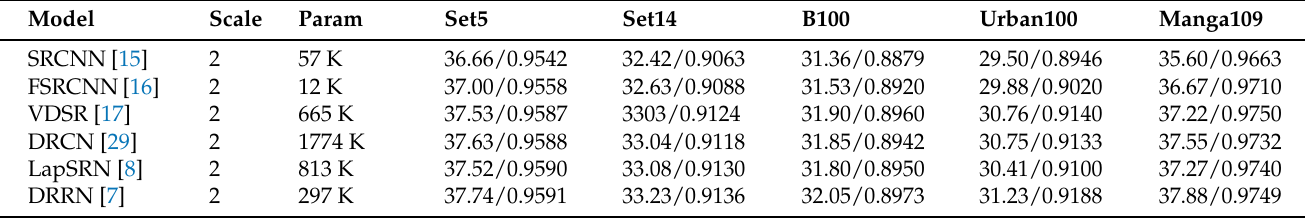
Table 7. Quantitative comparisons (PSNR (DB)/SSIM for 2 × , 3 × and 4 × ) of SOTA SR models. Red/blue text means the best/second-best